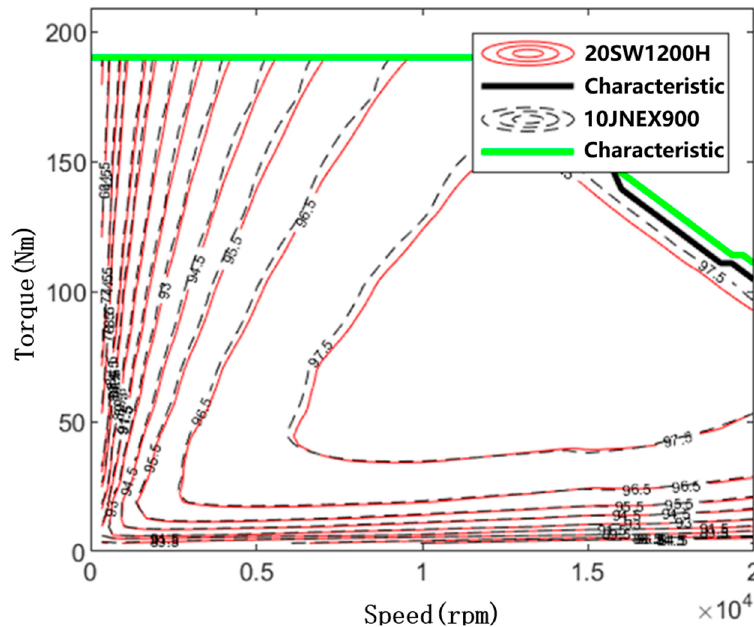
Figure 13. 10JNEX900 and 20SW1200H motor efficiency MAP comparison.